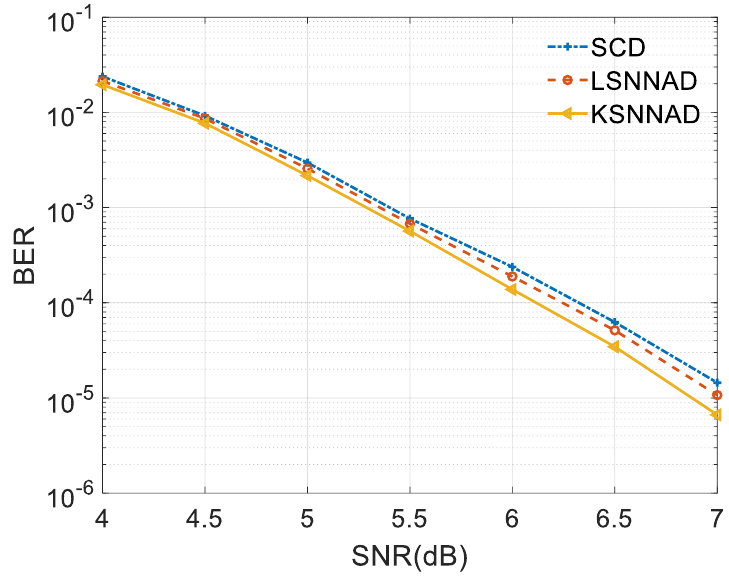
16 of 21 Figure 16. Decoding results of different decoding schemes. As shown in Figure 16, t he BER curves of SCD, SSCD and SCLD with L = 1 are just the same. The BER performance of LSNNAD scheme was slightly worse than NSCD and RTD with = 6  , whereas the performance of KSNNAD is better than FSCFD with 3 m a x T = and worse than SCL decoder with L = 2. 4.5. Performance Comparison under Rayleigh Channel A transmitted signal s passes through the Rayleigh flat-fading channel, and the re- ceived signal can be expressed as follows: R e